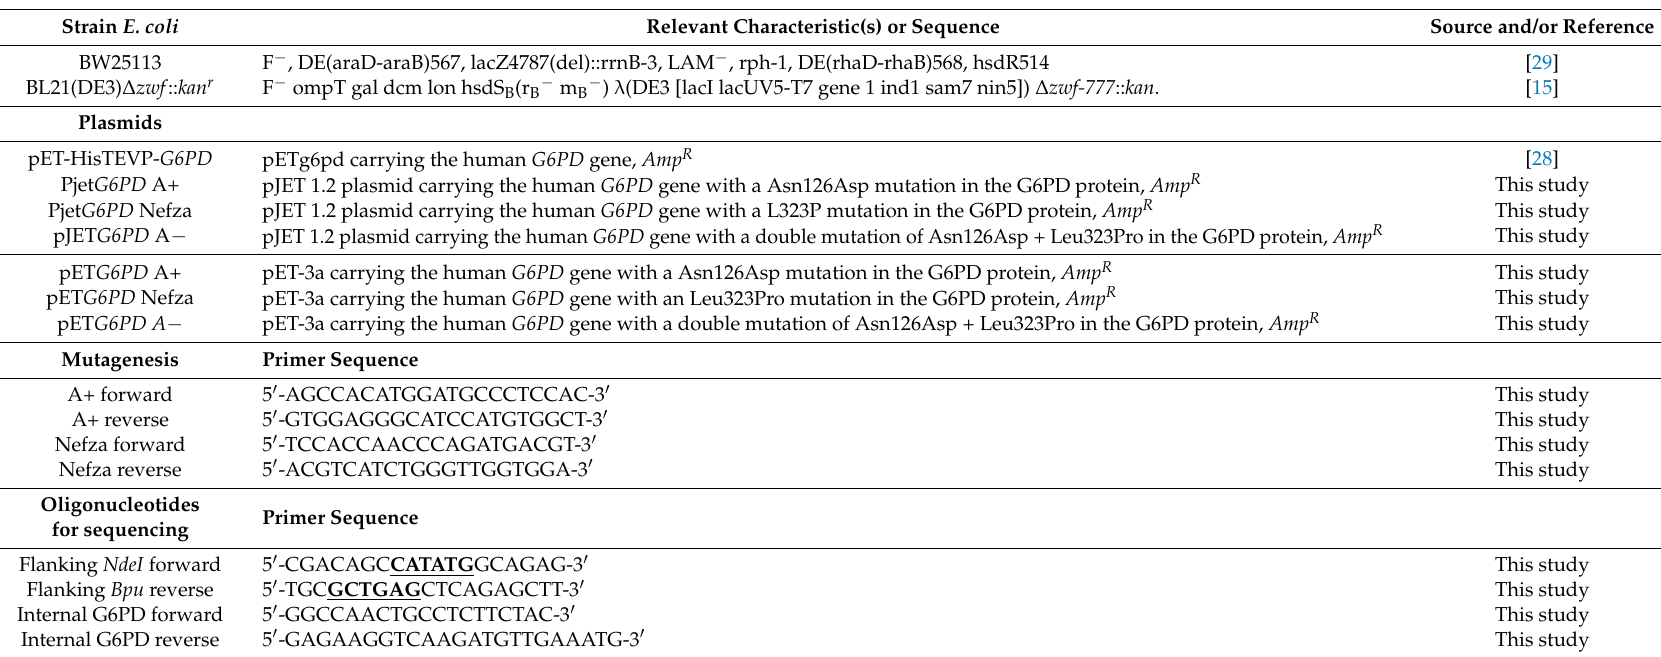
Table 3. List of primers used in this